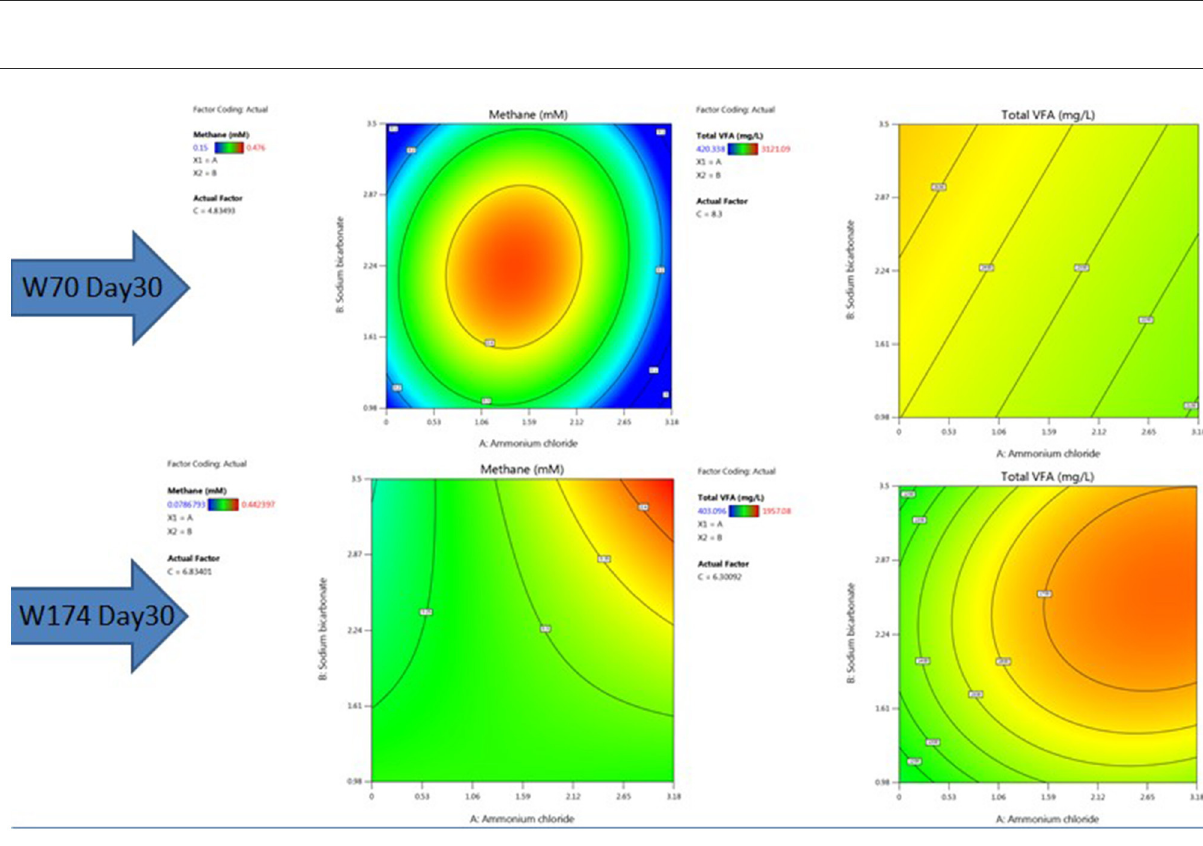
FIGURE7 RSM contour plots of the interactive effect of ammonium chloride, sodium bicarbonate, and molasses after 30 days with TERIW70 and